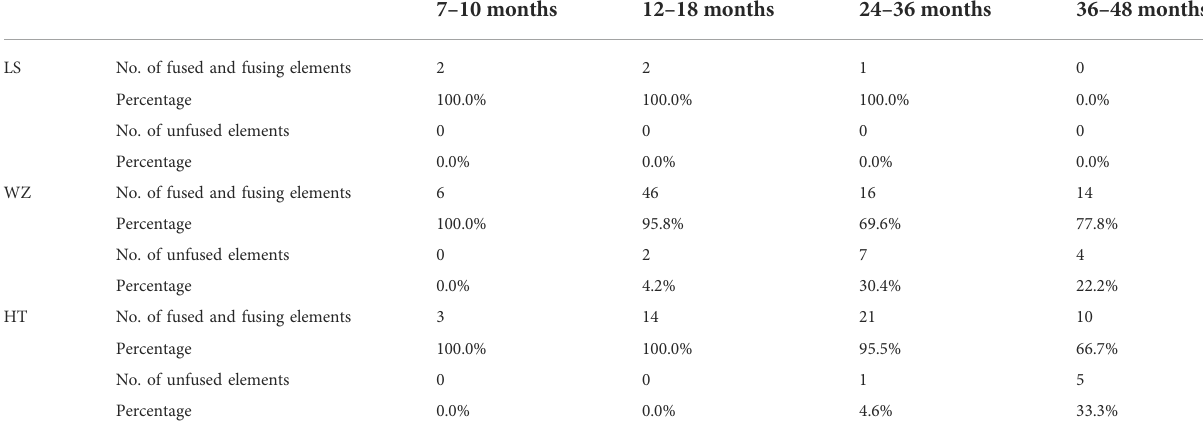
TABLE 3 Bone epiphyseal fusion of cattle from Xitou.